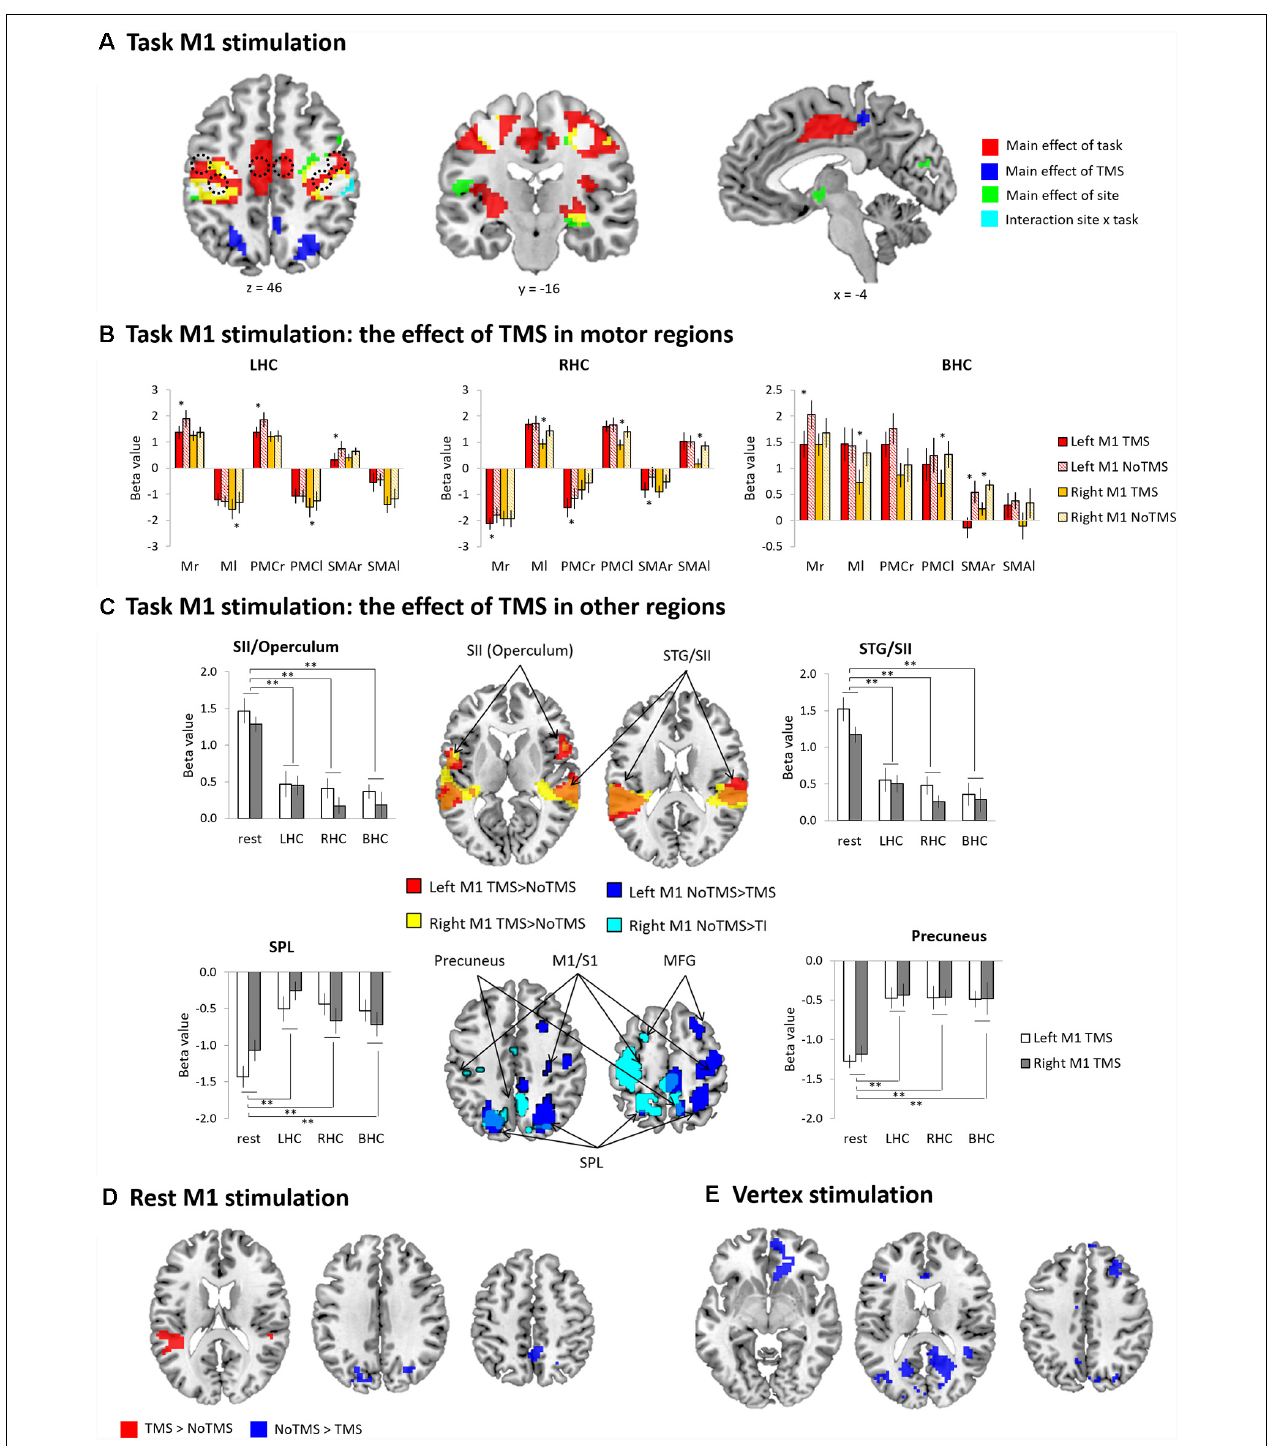
FIGURE 2 | General linear model (GLM) results (A) task primary motor cortex (M1) stimulation whole-brain activation map. Red (main effect of task), Blue (main effect of TMS), Green (main effect of site), Cyan (interaction between task and site), and White (overlapping areas across the contrasts). (B) The results of ROI analysis in the motor regions [M1, premotor cortex (PMC), and SMA]: Task M1 stimulation. The bar filled color indicates the TMS phase and the bar filled with diagonal lines indicates the No TMS phase. Red (left M1 TMS) and Yellow (right M1 TMS). (C) The results of conjunction analysis: Task M1 stimulation. (D) Rest M1 stimulation whole-brain activation map. Red (TMS > NoTMS) and Blue (NoTMS > TMS). (E) Vertex stimulation whole-brain activation map. Red (TMS > NoTMS) and Blue (NoTMS > TMS). Error bars indicate standard errors. ∗ p < 0.05, ∗∗ p < 0.005.